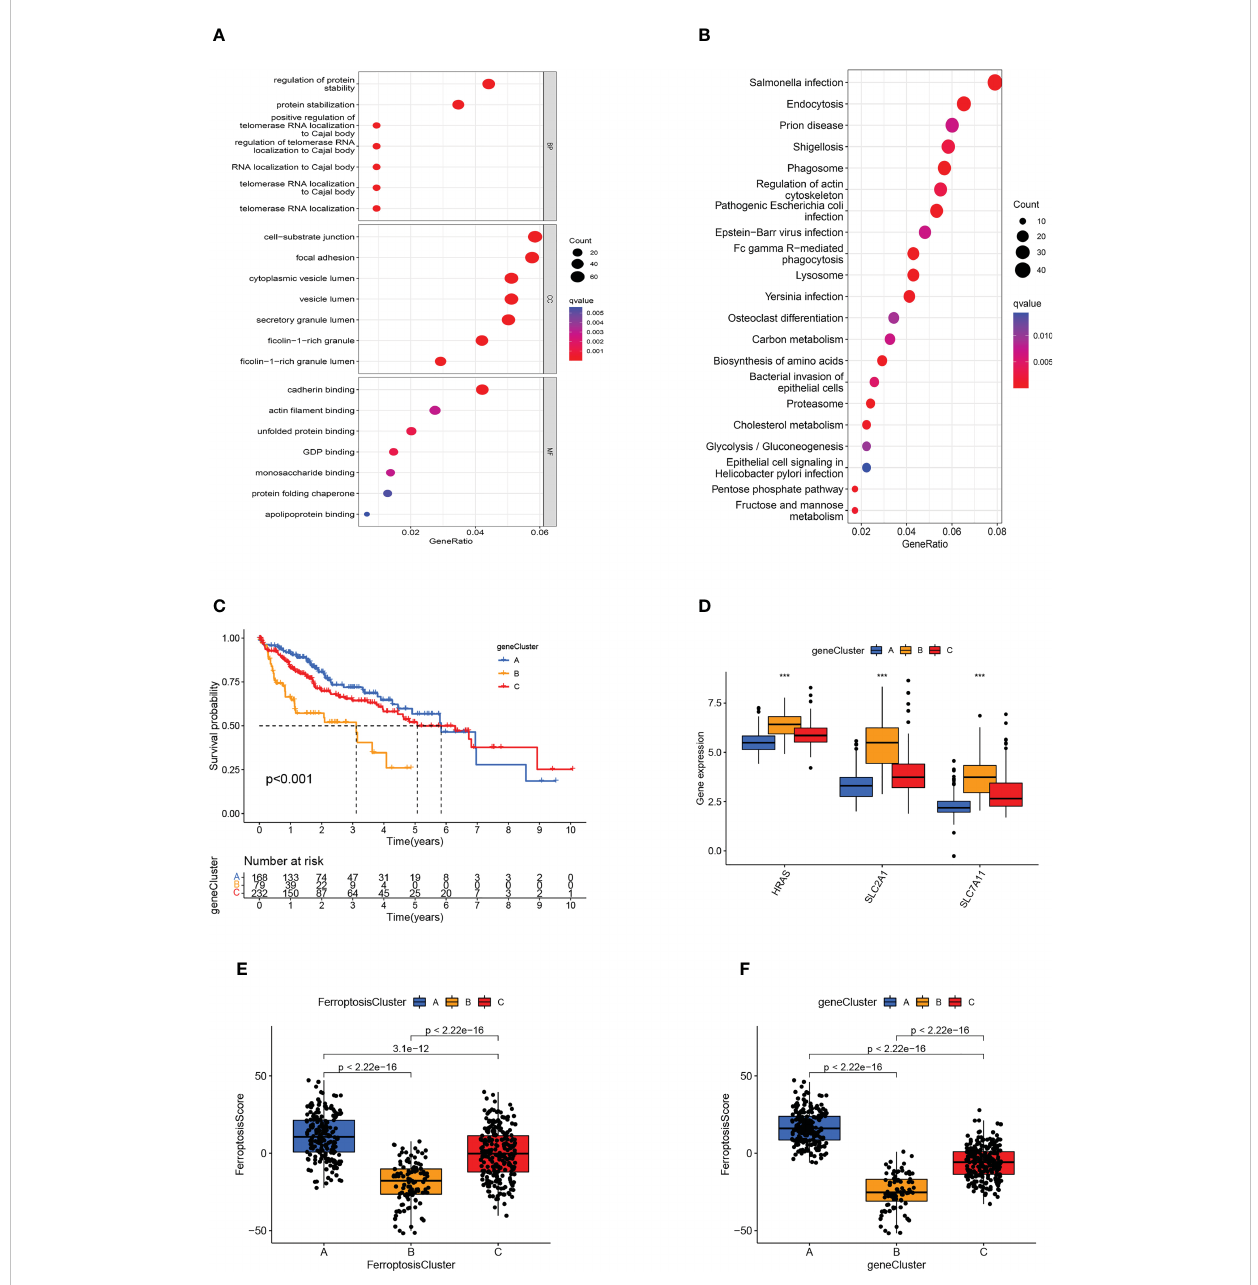
FIGURE 5 Generation of ferroptosis-related genomic patterns and the ferroptosis score. (A, B) GO (A) and KEGG (B) analysis based on differentially expressed genes. (C) Kaplan-Meier curves for the three gene clusters of HCC patients. (D) Box plots showed hub gene expression in the three gene clusters. *** p <0.001. (E, F) Box plots displayed the differences in ferroptosis scores among the three ferroptosis clusters (E) and the three gene clusters (F)